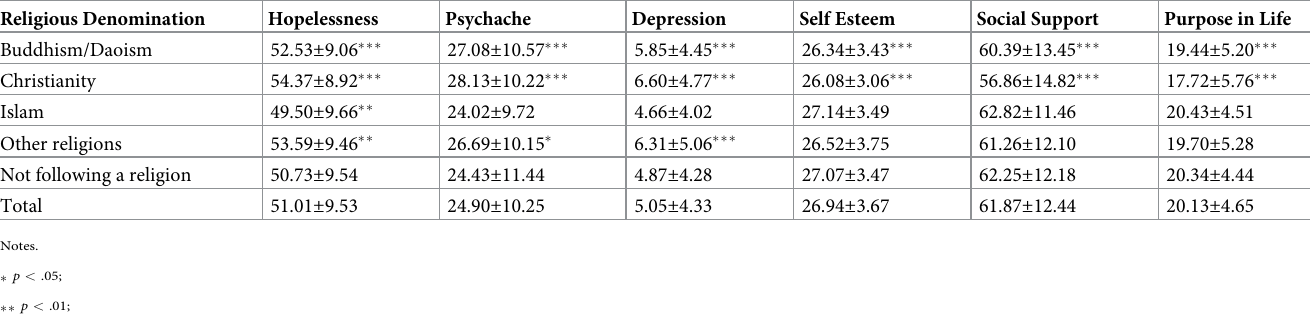
Table 2. One-way ANOVA analysis comparing hopelessness, psychache, depression, self-esteem, social support, and purpose in life by religious